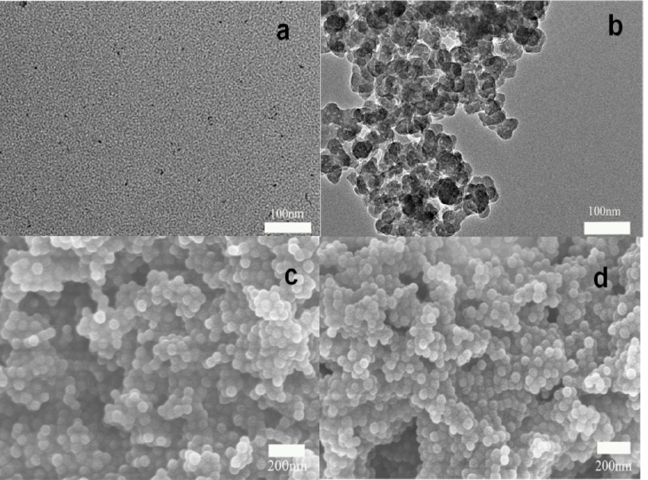
Figure 2. TEM images of CdTe QDs ( a ) and MIP@SiO 2 @QDs ( b ), SEM images of NIP@SiO 2 @QDs ( c ) and MIP@SiO 2 @QDs ( d ).